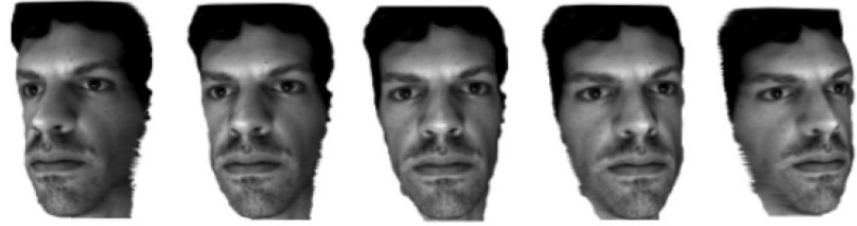
Figure 19. Example head views generated for printing.